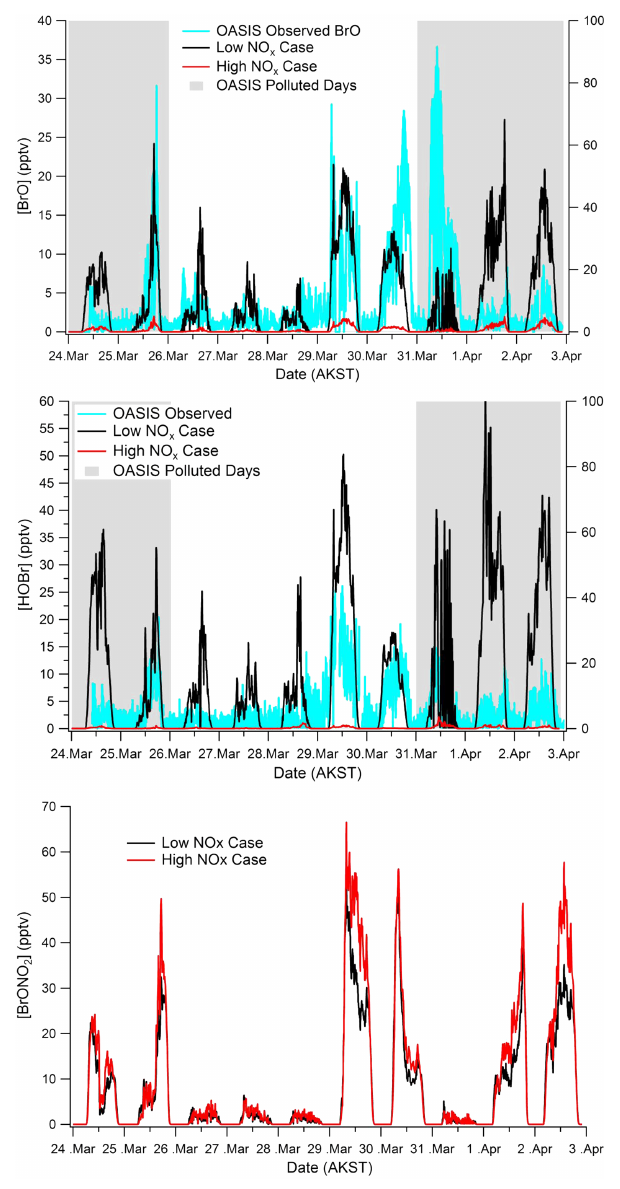
Figure 7. (a) Simulated BrO mixing ratio (low NO x & high NO x cases) and the observations during the study period. (b) HOBr levels from the model simulations (low NO x & high NO x cases) and the observations during the simulation dates. (c) BrONO 2 mixing ratio from the two simulation cases.